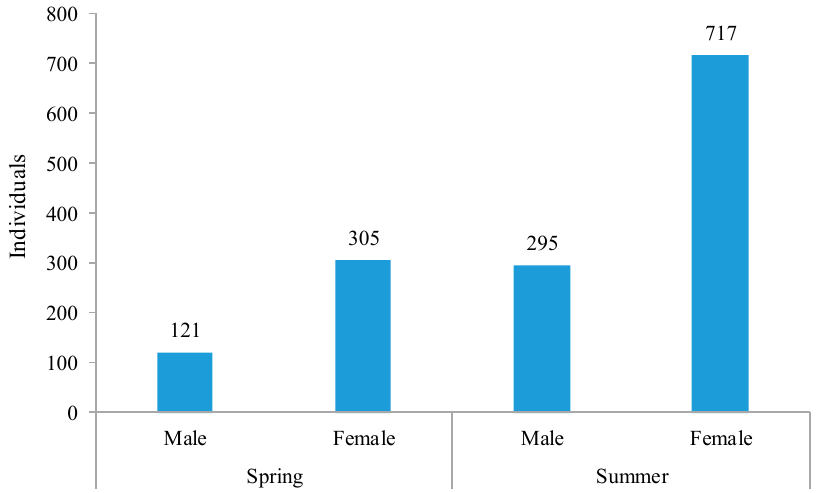
Figure 4. Total emergence of male and female Megachile cephalotes in spring and summer seasons